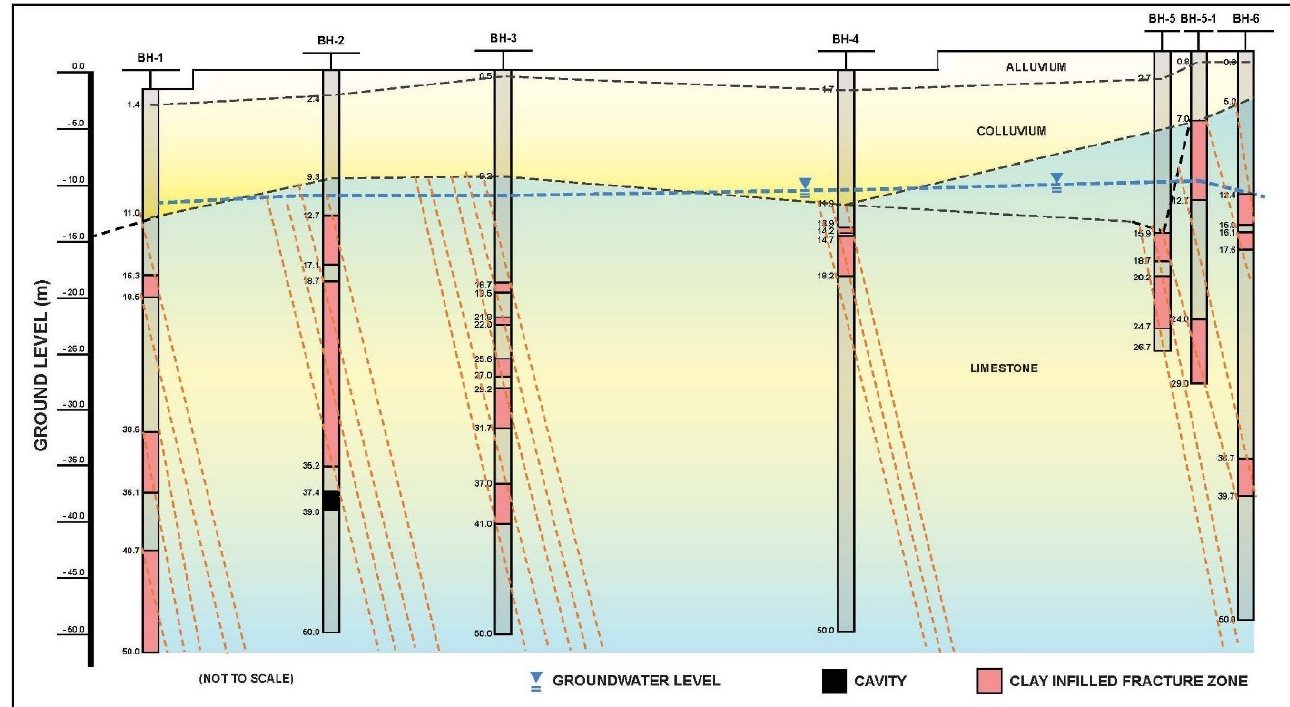
Figure 21. Reinterpreted geological section along BH − 1 to BH − 5.